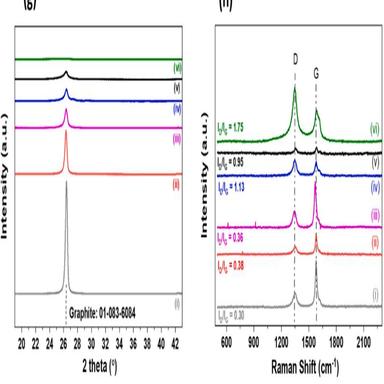
Secondary electron SEM images of pristine graphite (a), milled graphite (b), B-graphite (c), N-graphite (d), S-graphite (e), and I-graphite (f). XRD patterns (g) and Raman spectra (h) of the pristine graphite (i), milled graphite (ii), B-graphite (iii), N-graphite (iv), S-graphite (v), and I-graphite (vi).